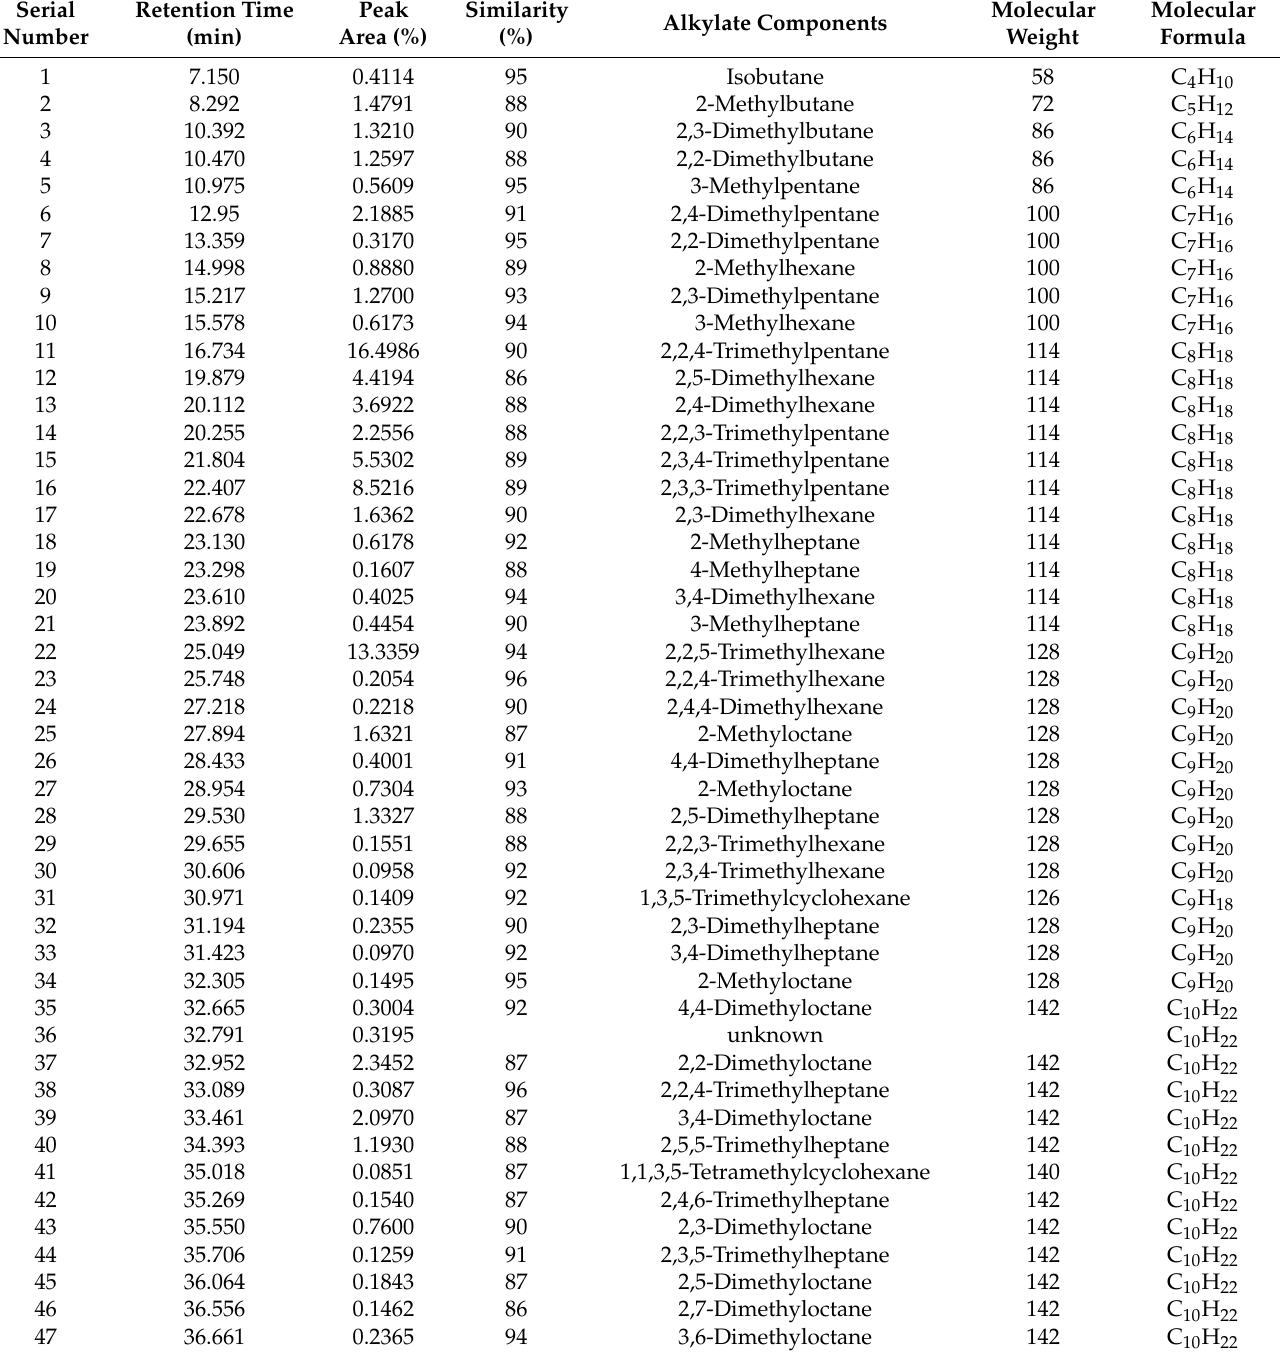
Table 5. CGC-MS-DS analysis results of the alkylation